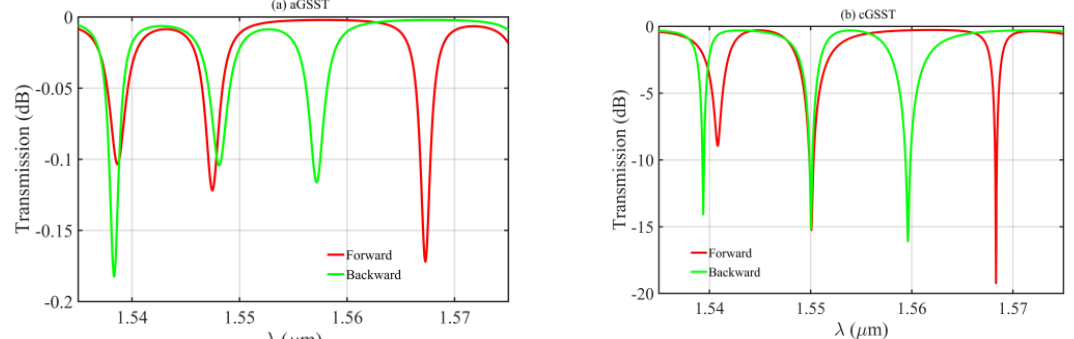
= 5.573156 × 10 − 8 and n k ef f ,aGSST